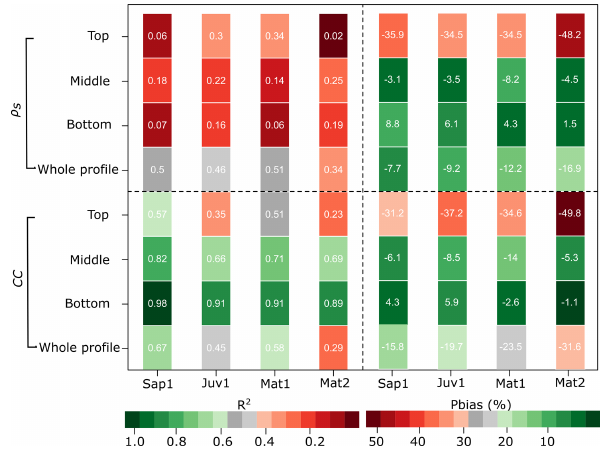
Figure 8. Performance of CC and density simulations following the adopted hybrid procedure, coefficient of determination ( R 2 , left), and percent bias (Pbias, right). Pbias colour bar applies to both pos- itive and negative values.